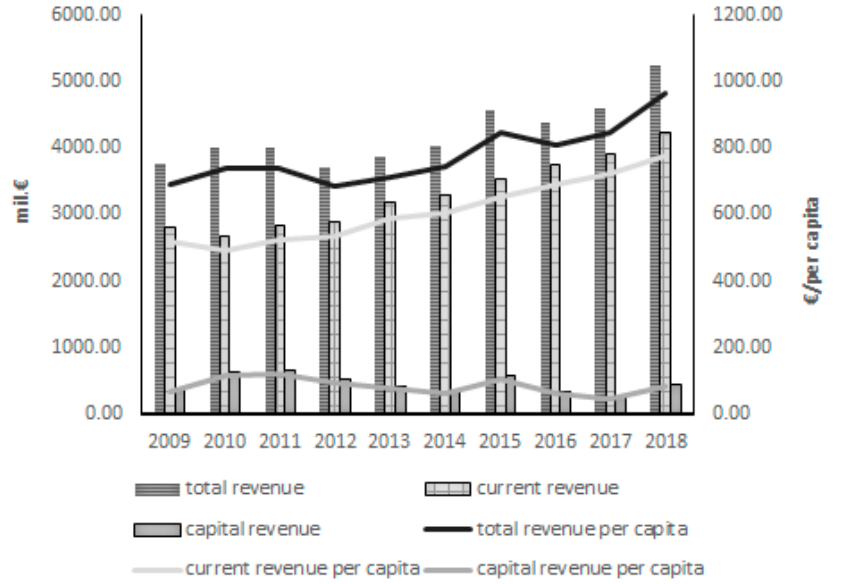
Figure 1. The development of total revenues, current revenues, and capital revenues of the municipalities in Slovak Republic in the time period 2009–2018, Source: Ministry of Finance of Slovak Republic (2020a), Ministry of Finance of Slovak Republic (2020b), own processing.